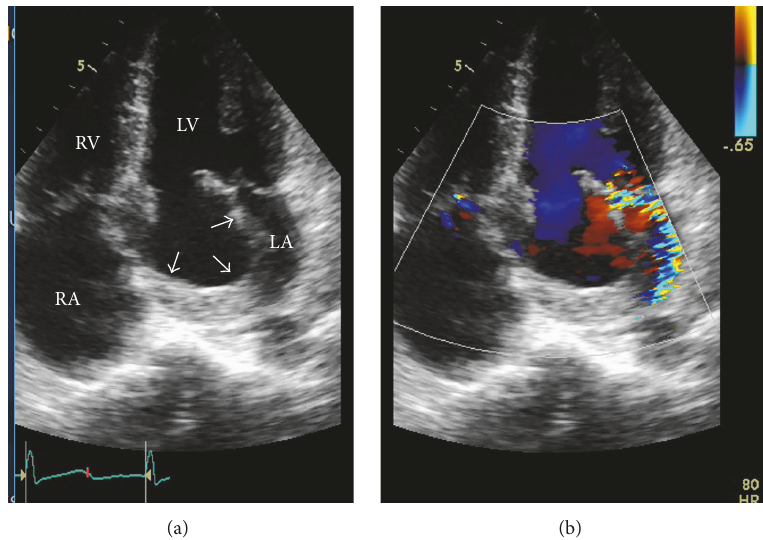
Figure 2: Apical 4-chamber view showing the mass (arrows) mimicking anterior leaflet aneurysm. Color Doppler (b) shows systolic flow into the mass in addition to eccentric MR. LV: left ventricle, LA: left atrium, RV: right ventricle, RA: right atrium, and MR: mitral